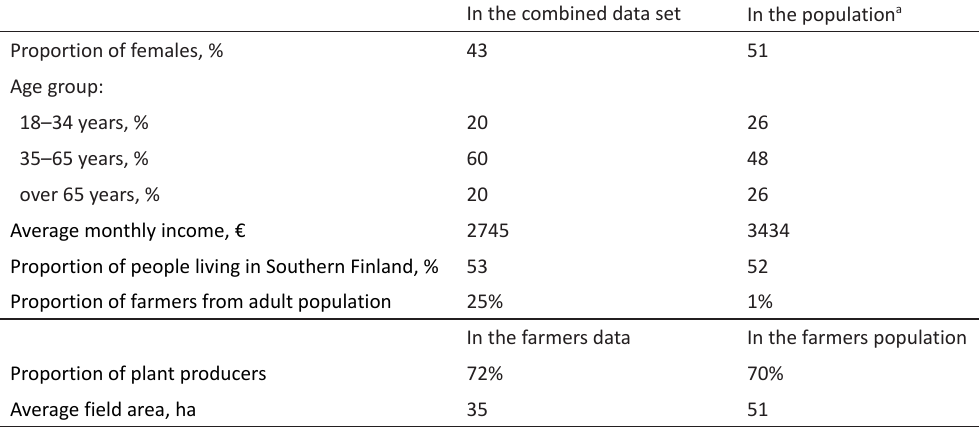
Table 1. Some key sociodemographic variables in the data set and the Finnish population In the combined data set In the population